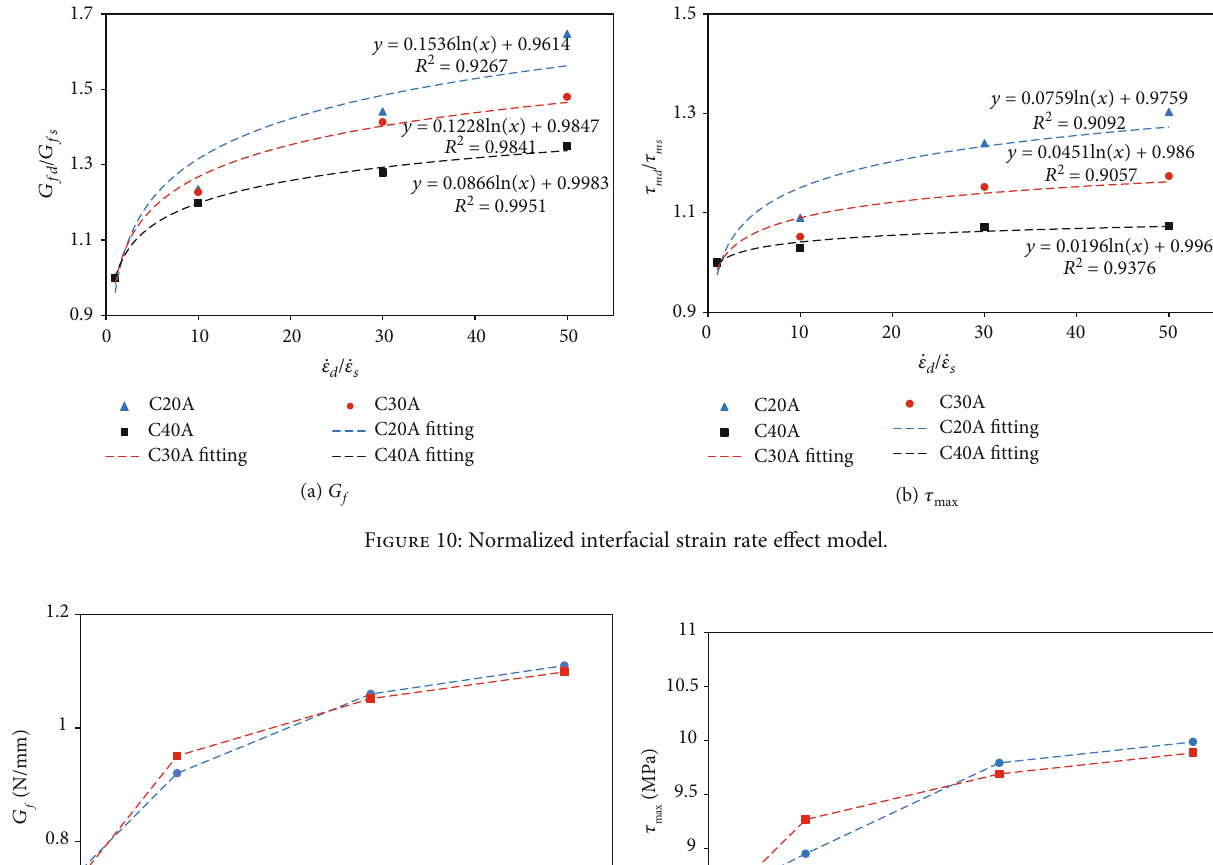
Figure 11: Comparison of G